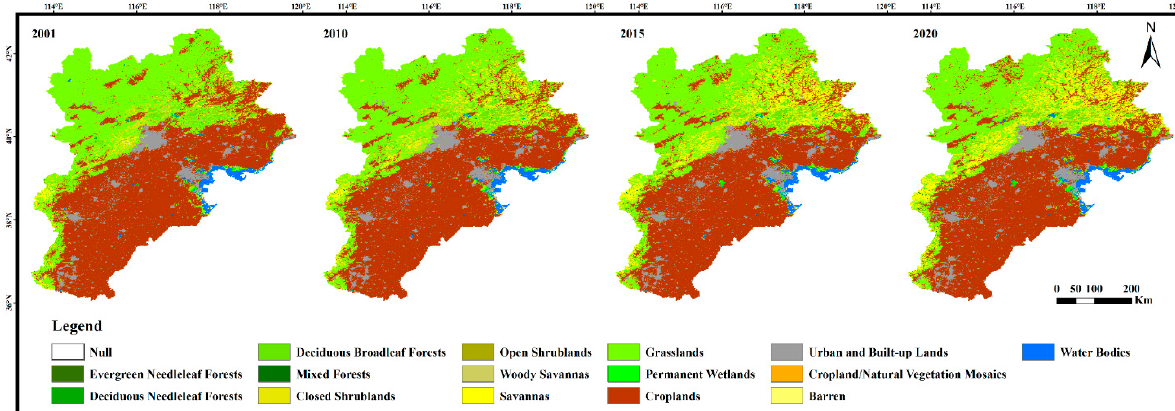
Figure 4. The MODIS IGBP landcover of Beijing–Tianjin–Hebei in 2001, 2010, 2015, and 2020.